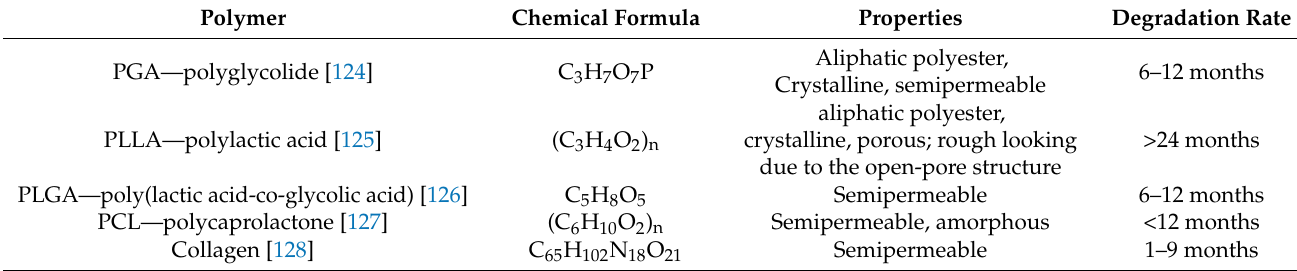
Table 3. Commonly used Polymers and Their